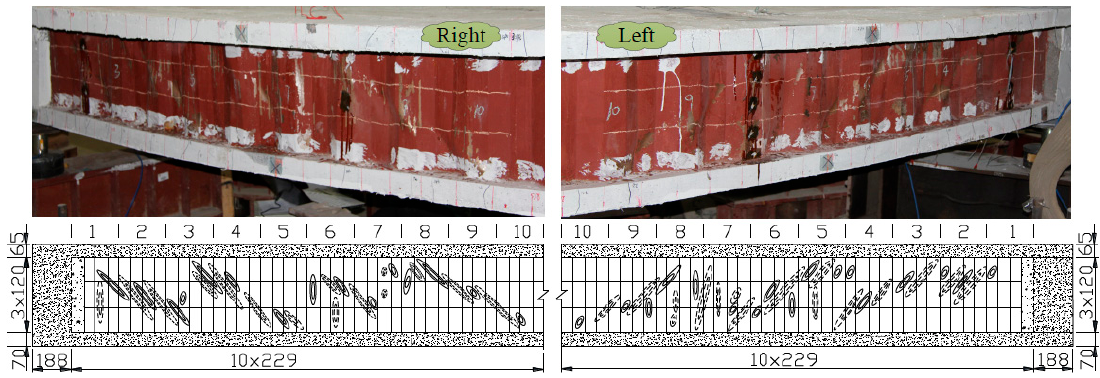
Figure 16. The final buckling shapes of outer CSW for specimen S3-t2d3. Right: the right-hand side of test girders. Left: the left-hand side of test girders.